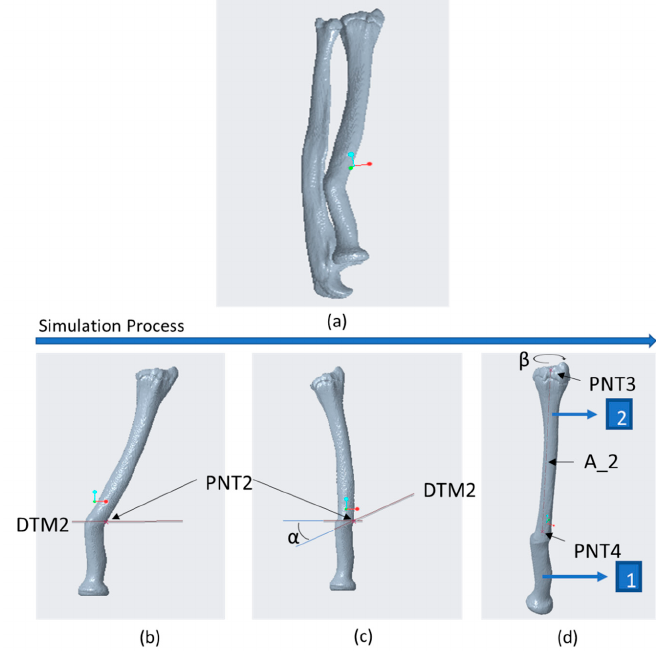
Figure 9. On the basis of the analysis of Miyake [16,17], a new 3D parametric simulation ( a ) was performed to realign the bones, enabling the achievement of a normal range of motion [18,19]. For the rotational analysis, the cutting plane DTM2 and the rotation point PNT2 were defined. PNT2 stands at the most external edge of the radius on DTM2 ( b ); the simulation process allowed us to calculate the α angle required to achieve the angular realignment ( c ); through torsional simulation [20], points PNT3, PNT4, and the resultant axis A_2 were defined. Around the latter a torsion of β = 25 degree was performed to guarantee the optimal configuration of the bone ( d ).